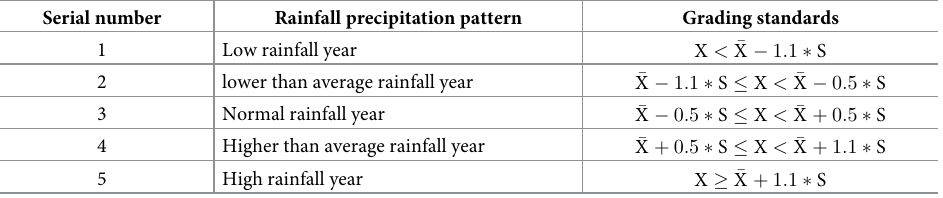
Table 3. Rainfall precipitation pattern classification